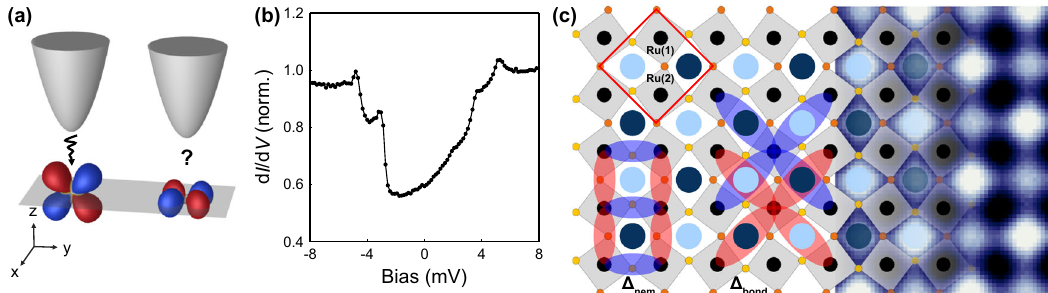
Fig. 1 Electron tunneling and nematicity at the surface of Sr 2 RuO 4 . a The out-of-plane symmetry of a d yz orbital suggests a high probability of electron tunneling from a metallic tip and a signi fi cant contribution to the tunneling current. For an in-plane atomic orbital, such as d xy , the overlap with the tip orbitals is small, suggesting negligible contribution. b High-resolution differential conductance (d I /d V ) spectrum at T = 76 mK, showing the characteristic gap-like structure at the surface of Sr 2 RuO 4 ( V set = 8 mV, I set = 500.2 pA, V L = 155 μ V). Four peaks can be clearly identi fi ed which are associated with the d xy -derived γ -band 22 . c Sketch of the structure of the reconstructed surface of Sr 2 RuO 4 with RuO 6 octahedra rotated by the angle ϑ = 6 ∘ . The experimentally observed checkerboard charge order (right-hand side) is equivalent to the breaking of C 4 -symmetry rendering the two Sr atoms (dark blue and light blue) and oxygen bonds along the horizontal and vertical direction inequivalent (indicated by orange and yellow circles) 22 . This symmetry breaking is described by a nematic order with d x 2 (cid:2) y 2 symmetry ( Δ nem , red and blue indicate positive and negative sign, respectively, of the order parameter). The checkerboard charge order can be accounted for either through an additional staggered bond-centered order ( Δ bond , colors as for the nematic order parameter), or through a staggered on- site order with different on-site energies for the d xy band at Ru(1) and